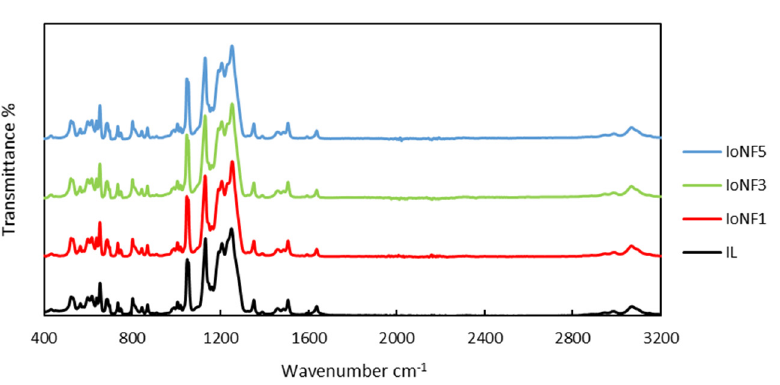
Figure 2. FTIR spectra of pure ionic liquid (IL) and of 3 IoNFs—full names in Table 1—with: 0.2 wt% xGnP (IoNF1); 2 wt% xGnP (IoNF3); and 8 wt% xGnP (IoNF5).